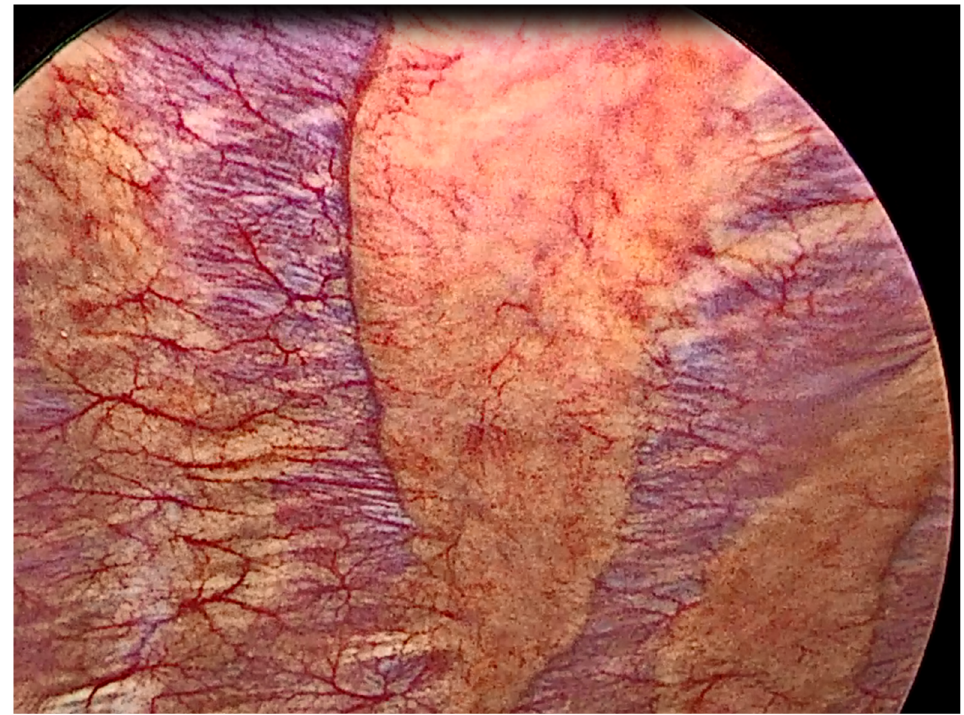
Figure 1. Thoracoscopic view of normal pleura.